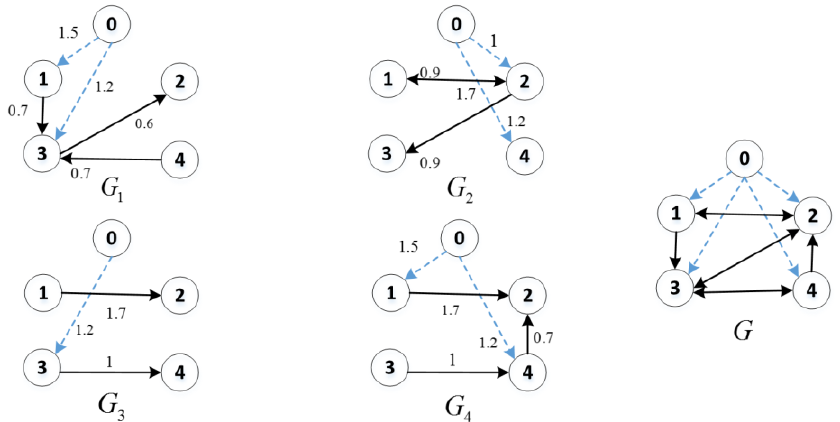
Figure 2. Set of communication topologies.